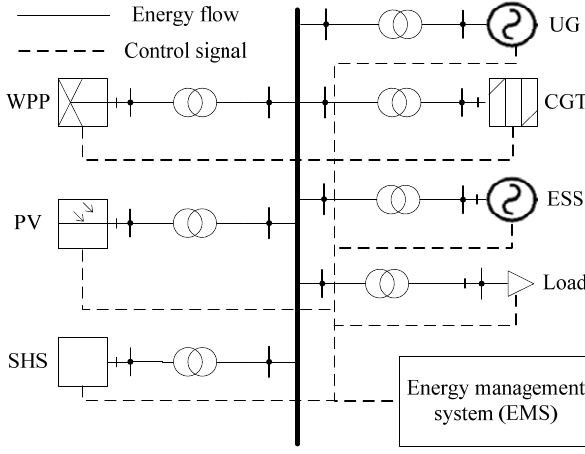
Figure 1. Basic structure of virtual power plant.